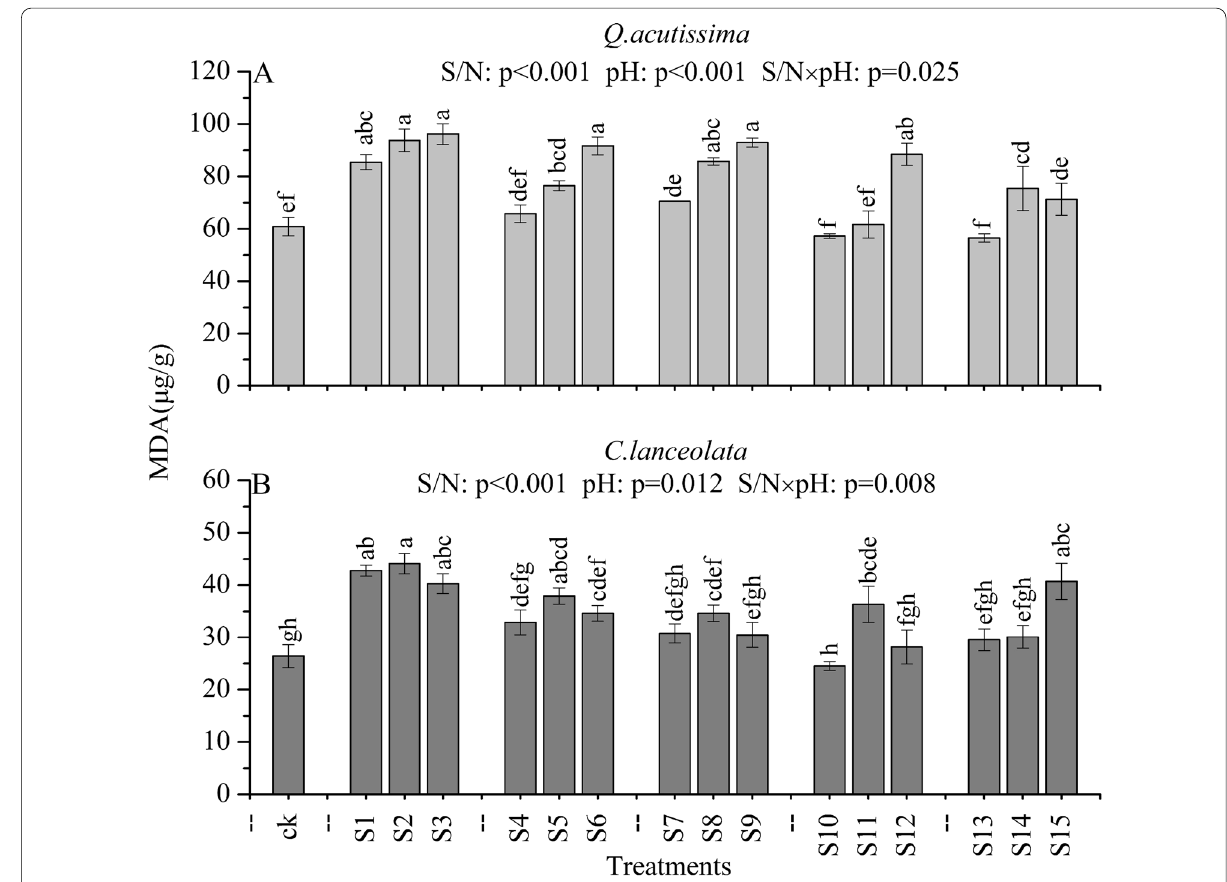
Fig. 3 Variations in root MDA contents between treatments. The analysis and meaning of the letters are consistent with Fig.